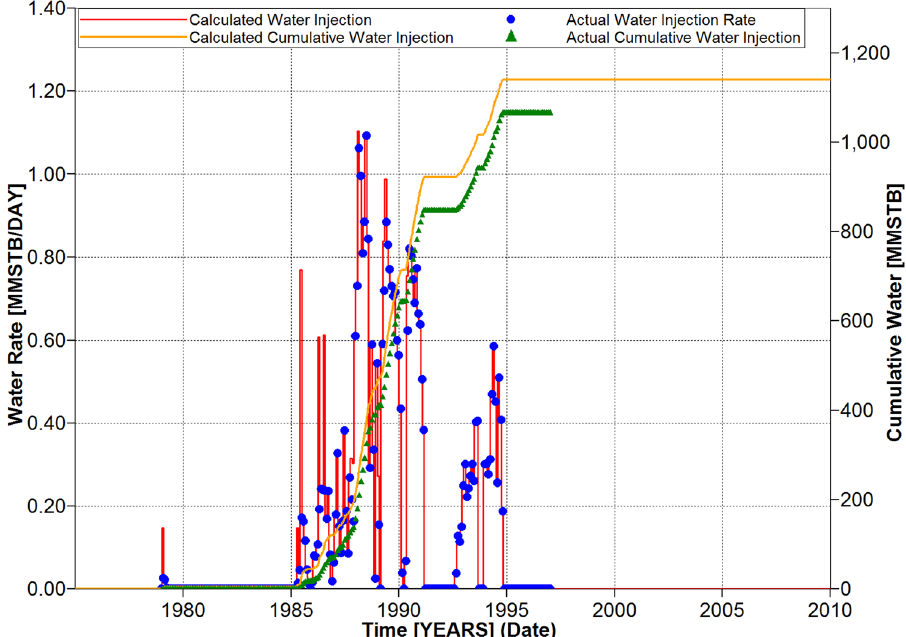
Fig. 6 History matching of